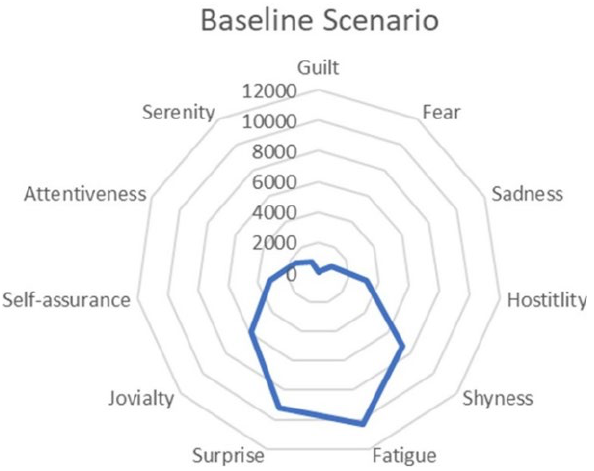
Figure 1. Radar Char (Baseline